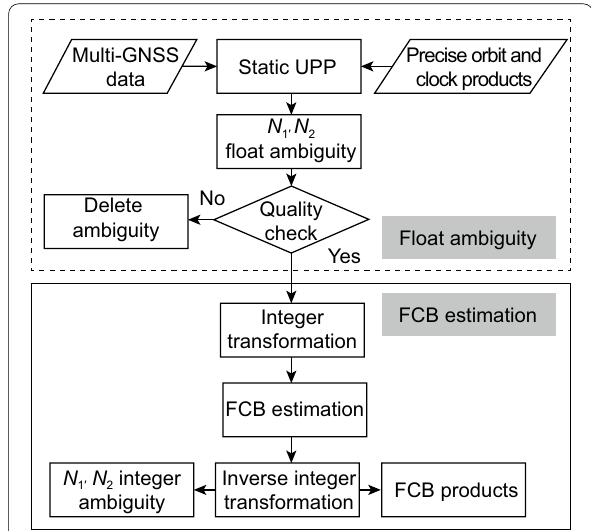
Fig. 1 Flowchart of FCB estimation using the individual ambiguities from the uncombined PPP model with the part of float ambiguity solutions in the red rectangle and the FCB estimation in the blue